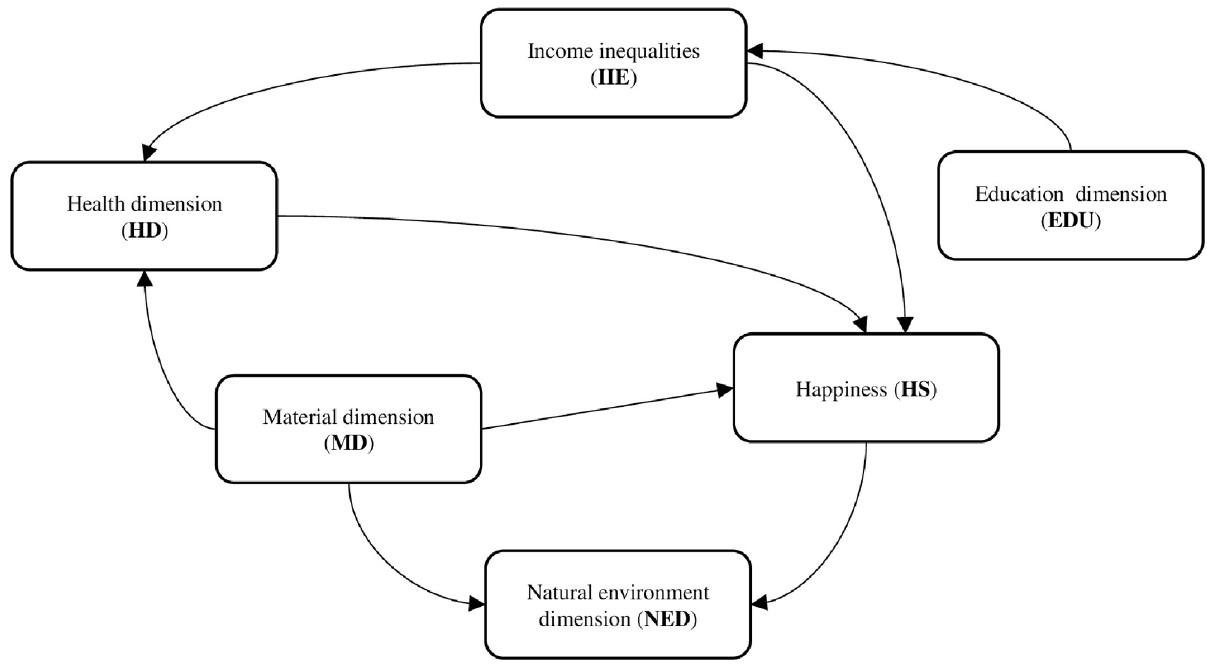
Fig 2. Scheme 1. Short-run links among income inequalities and dimensions of well-being—annual data. Source: own evaluation based on Table